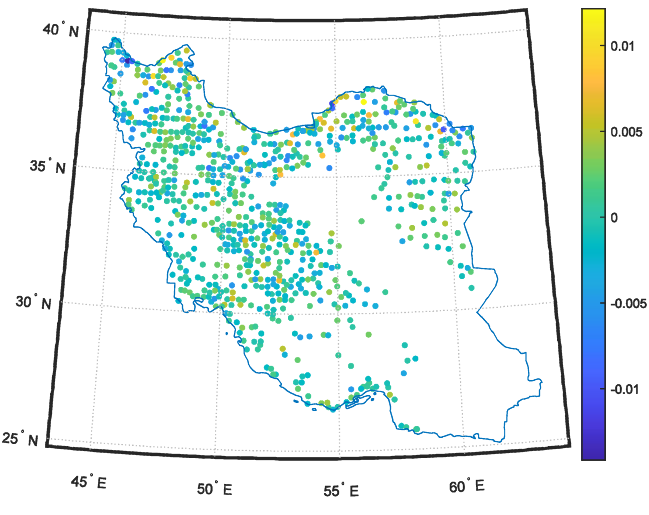
Figure 3 . Differences between the geoidal heights computed up to the degree of 2160 and 2190 for the XGM2019e_2159 model